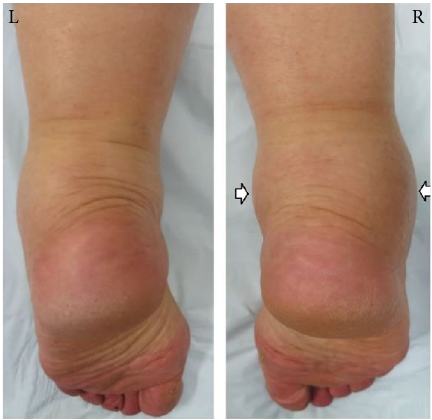
Figure 1: Preoperative photograph showing swelling of the posteromedial and posterolateral aspects (white arrows) of the right ankle.